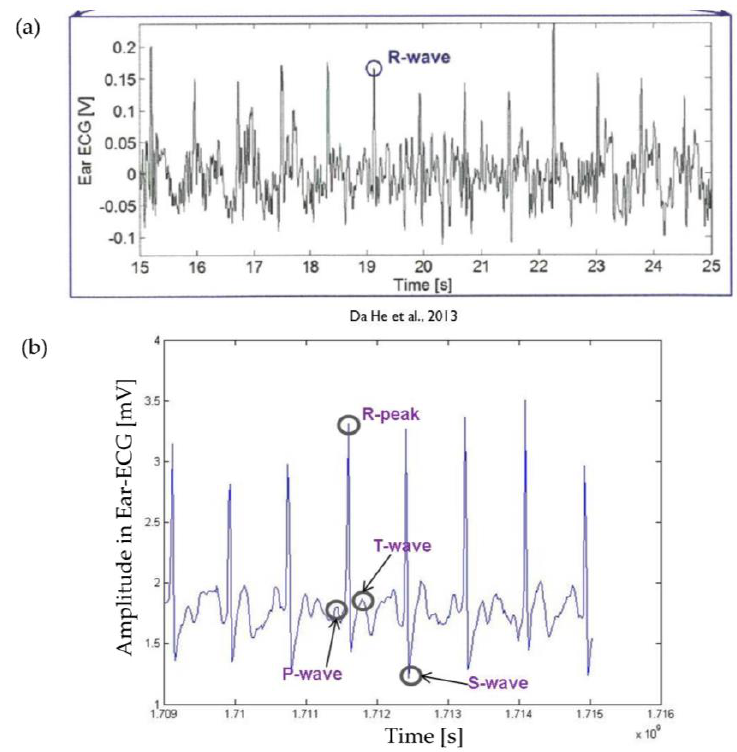
Figure 11. Comparison of ECG signals recorded by different electrodes. ( a ) ECG signals recorded by Ag/AgCl electrode in Da He’s report using ear-lead position (only R-peaks are visible); ( b ) ECG signals recorded by GN-based electrode using ear-lead position (all P-QRS-T morphology is identified).